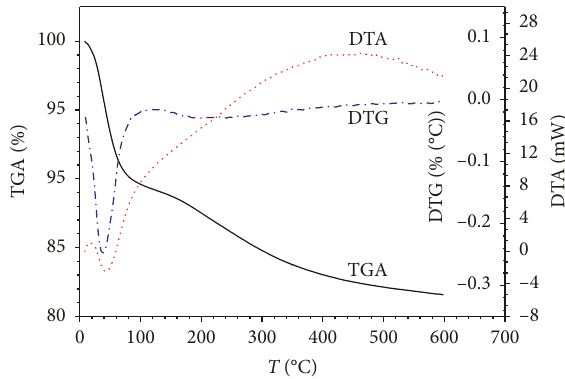
Figure 1: Thermal analysis data for